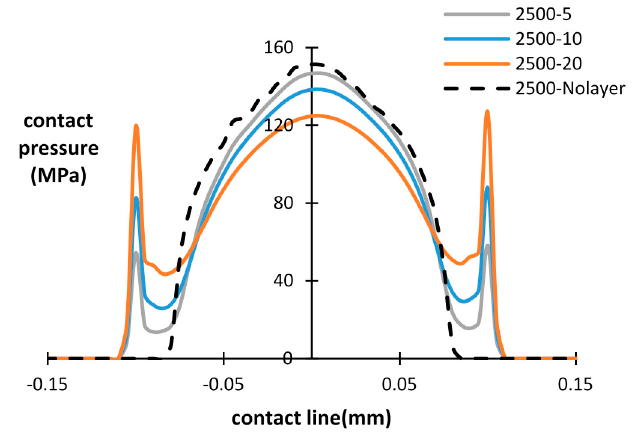
Figure 10. Contact pressure distribution for different layer thicknesses and number of cycles: layer thickness = 5 µm, 10 µm, 20 µm and without layer, after 2500 cycles.